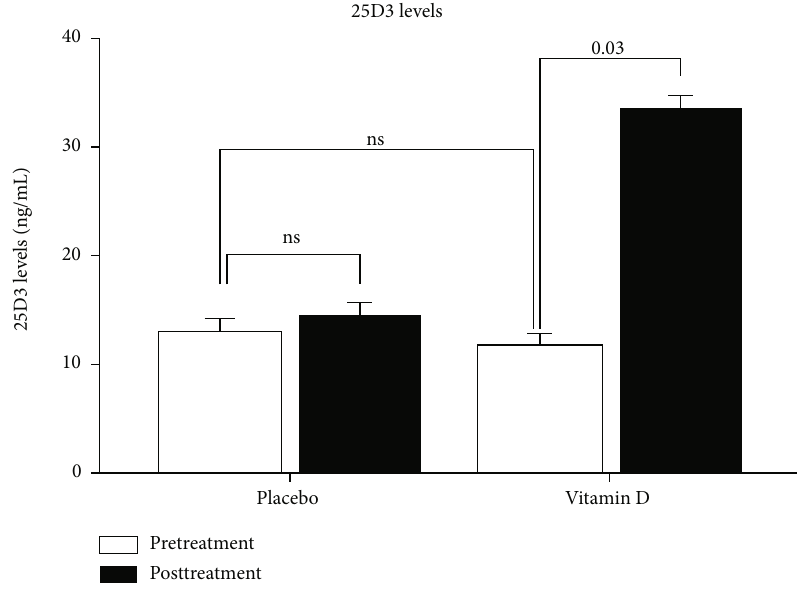
Figure 3: Pretreatment and posttreatment levels of serum vitamin D (25D3) in patients who received vitamin D or placebo for eight weeks. Asthmatic patients with vitamin D de fi ciency were divided into 2 groups. 23 patients received 50,000IU of vitamin D orally over 8 weeks, while 22 patients received placebo. Vitamin D levels were measured in the blood of these patients before and after the